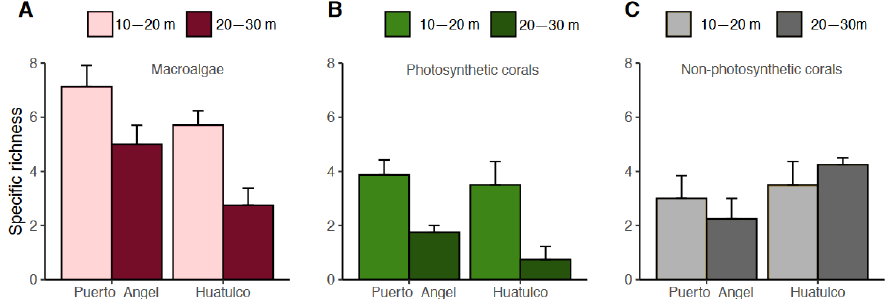
Figure 4. Specific richness in the two-depth strata and locations: ( A ) macroalgae; ( B ) photosynthetic corals; and ( C ) non-photosynthetic corals. Coral community structure changes were observed between the depth strata and with the variation in slope grade, which was reflected in different coral compositions through the “seascapes” (Figure 5). The spatial ordination of coral community structure (nMDS) revealed a clear separation between seascapes (Figure 5A), which present signif- icant differences (ANOSIM, R 2 = 0.57, p < 0.01), together with the associated variables “slope grade” (ANOSIM, R 2 = 0.44, p < 0.01), and depth (ANOSIM, R 2 = 0.21, p < 0.05). No differences were found among locations (ANOSIM, R 2 = 0.043, p = 0.163).